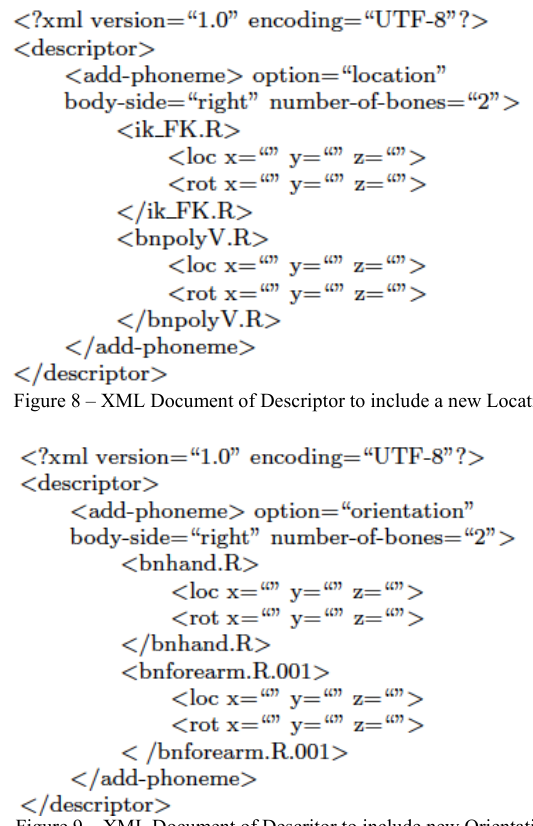
Figure 9 – XML Document of Descritor to include new Orientation